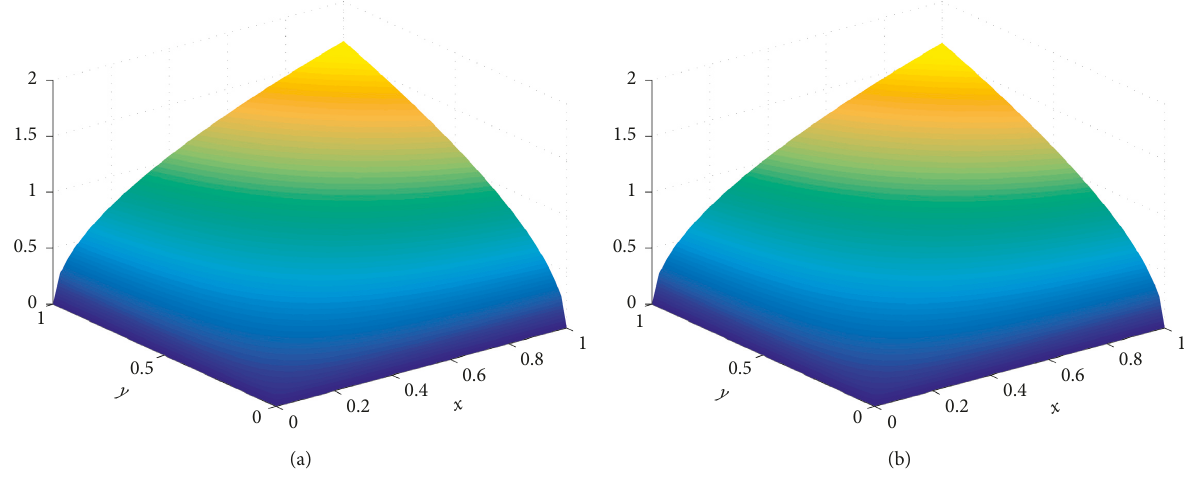
. (b) 􏽥 u ( x,t ) . exact LSRPSM